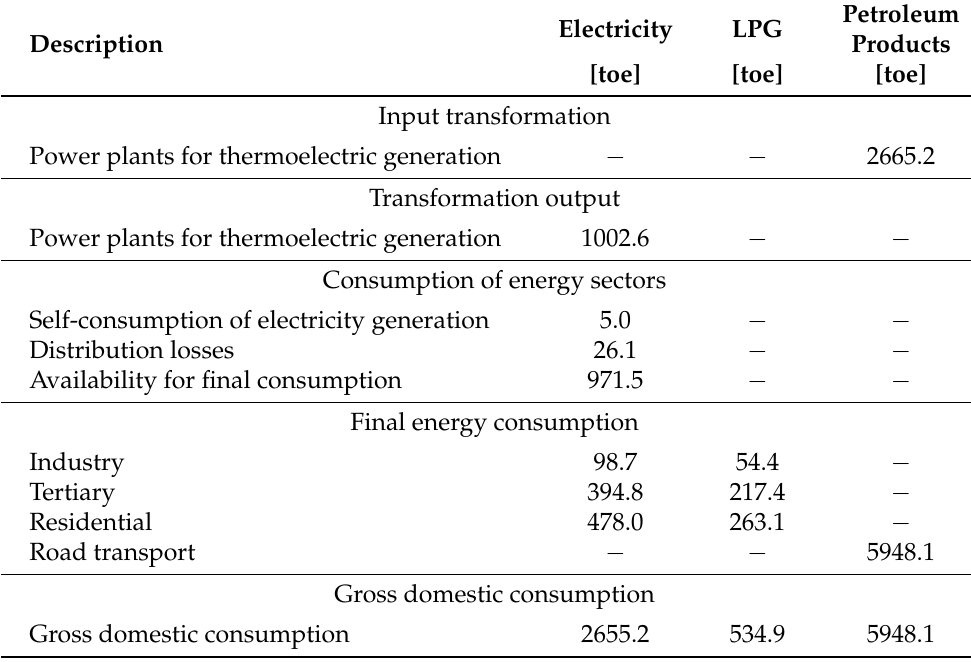
Table 6. Simplified energy balance (average of the years 2015 and 2016).